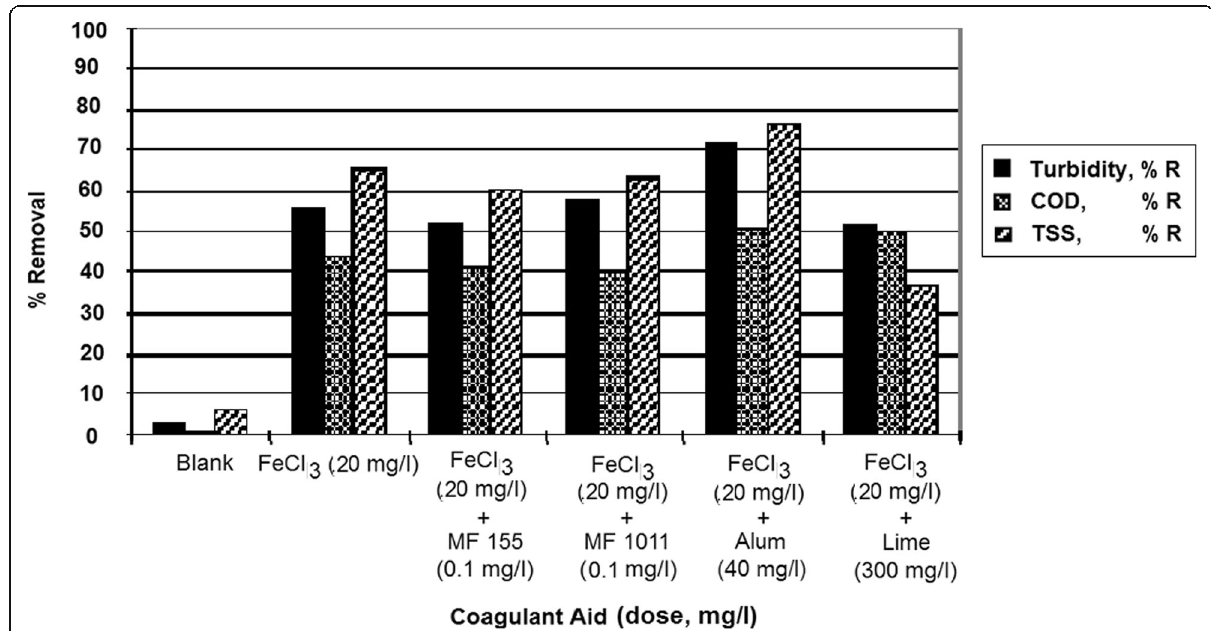
Fig. 2 Comparison between the use of Ferric chloride alone and in combination with coagulant aids and other coagulants